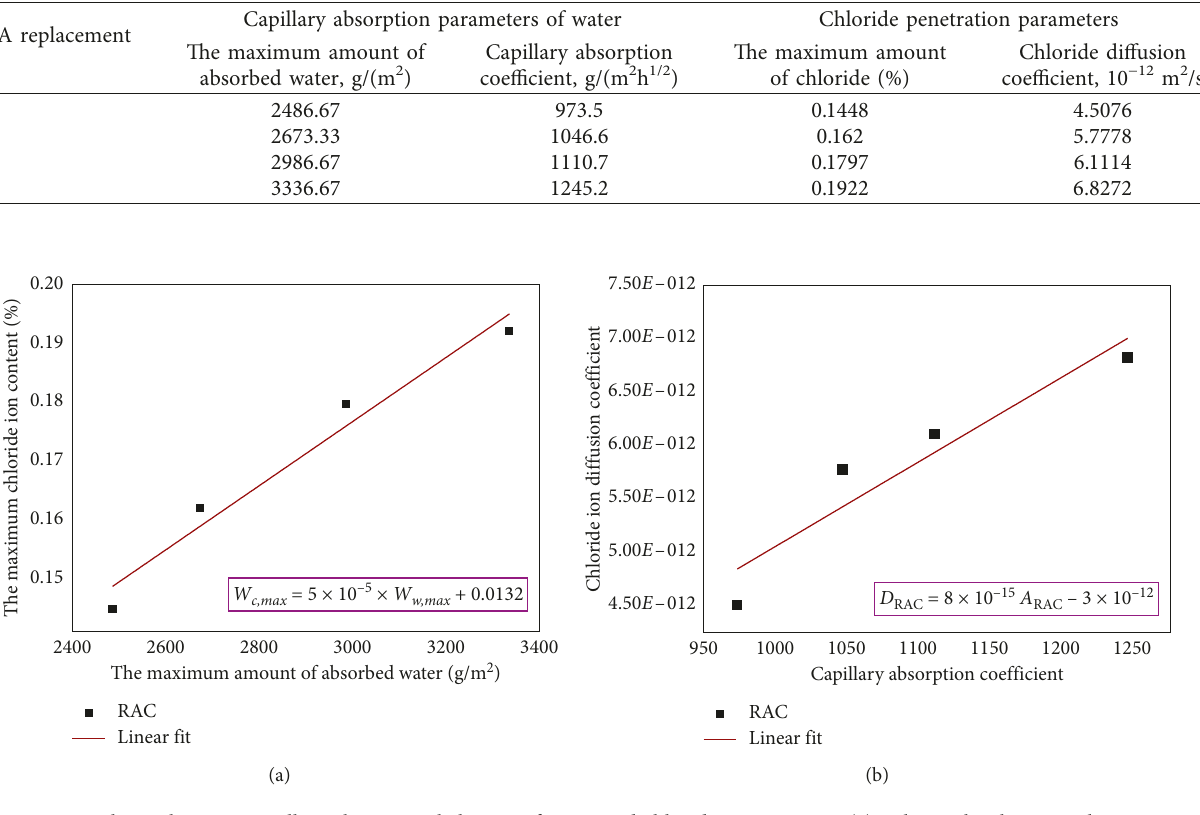
Figure 5: Correlation between capillary absorption behavior of water and chloride penetrations. (a) Relationship between the maximum amount of absorbed water and chloride content. (b) Relationship between capillary water absorption coefficient and chloride diffusion